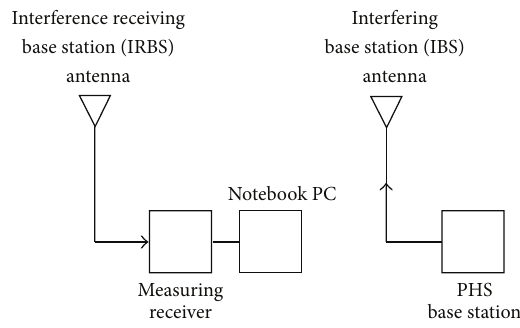
Figure 5: Block diagram of CCI measurement equipment.